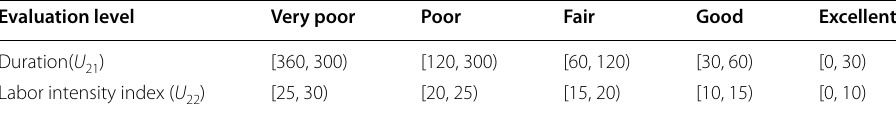
Table 3 Grade division of duration and labor intensity index Evaluation